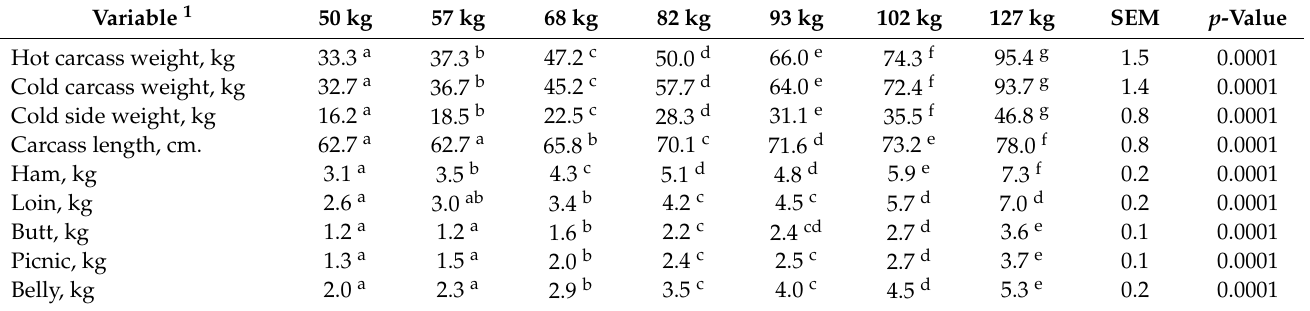
Table 3. Carcass parameters and primal cut measurements in Mangalica pigs at different weight